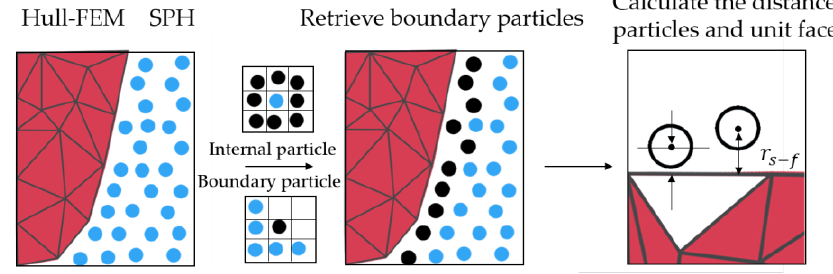
Figure 2. The relationship between boundary particles and cell surface.